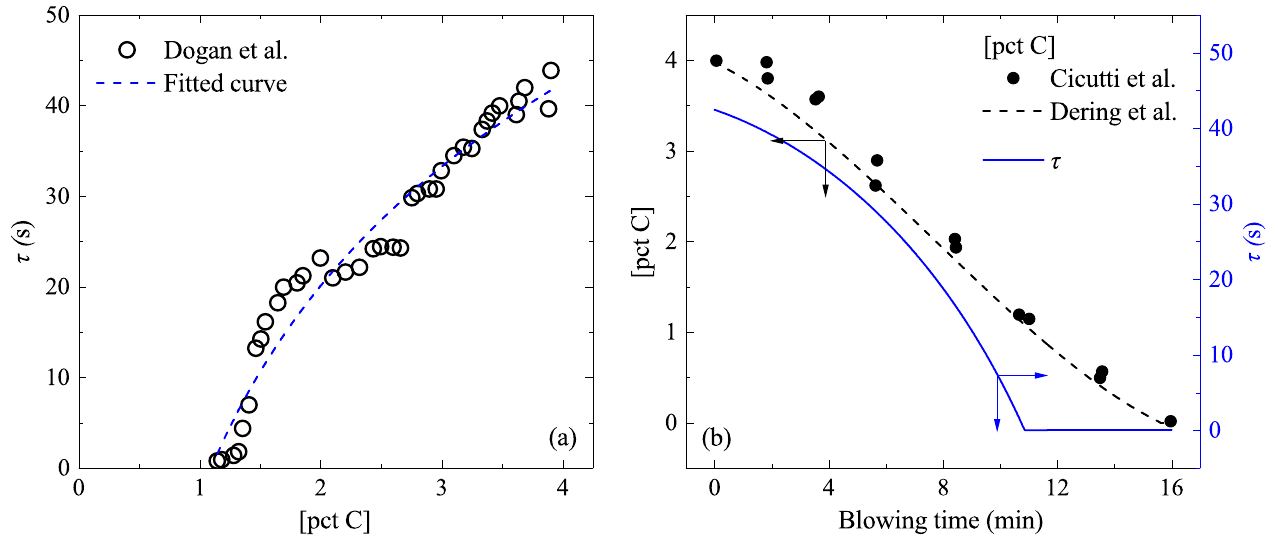
Figure 8. Residence time of the ejected droplets: ( a ) model predicted data (open circles) reported by Dogan et al. for the droplets having d = ∼ 2 mm in the emulsion [21], as a function of [pct C]. ( b ) [pct C] change reported by Cicutti et al. (closed circles) [27,32]. Dashed curve was fitted to these two sets of data [22]. A solid curve is the estimated residence time as a function of the blowing time. It is to be noted that τ is seen to level-off [pct C] < ∼ 1.1. This leads to an additional leveling-off in Figures 10, 11a, and 14. (color online)